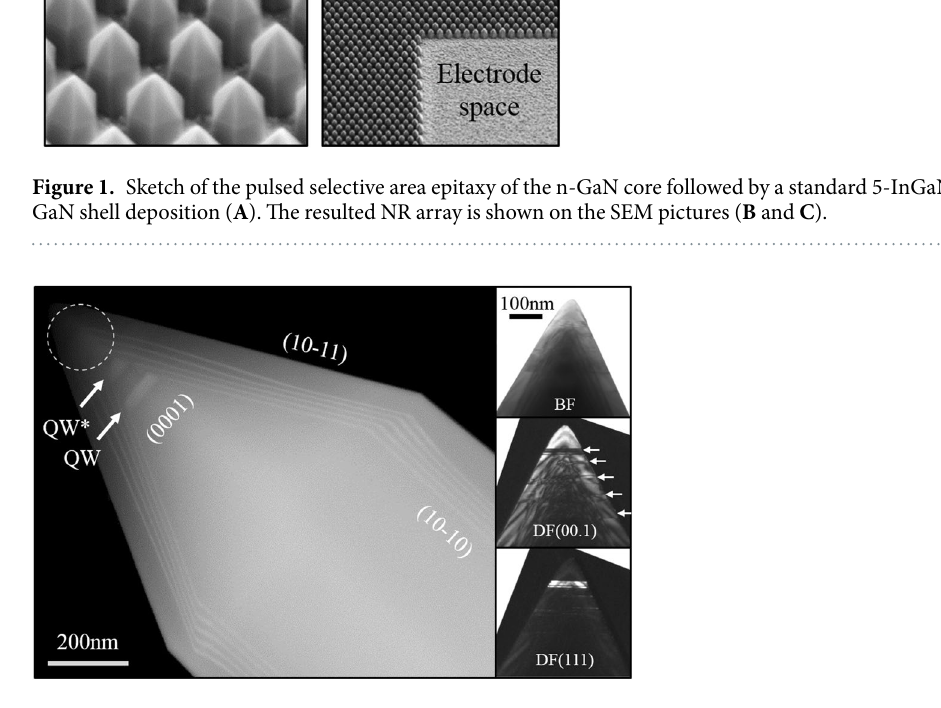
Figure 2. STEM picture of the core-shell layers structure. The right frame shows the presence of BSF in the tip of the NRs. The defects are highlighted under Bright Field (top) and Dark Field contrast (middle and